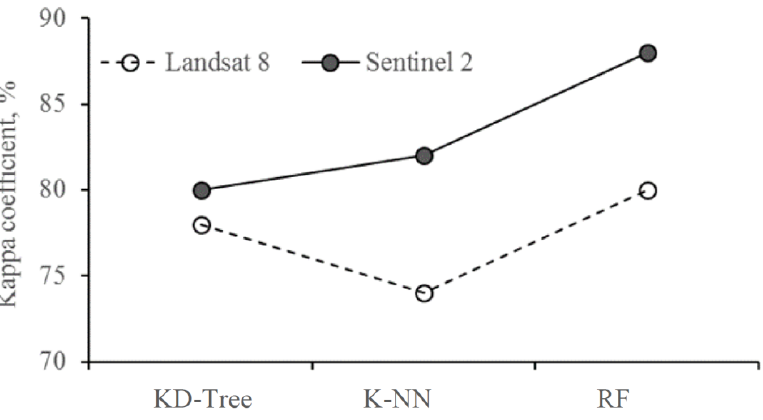
Figure 8. Kappa coefficient comparison of two satellites using different classifiers.